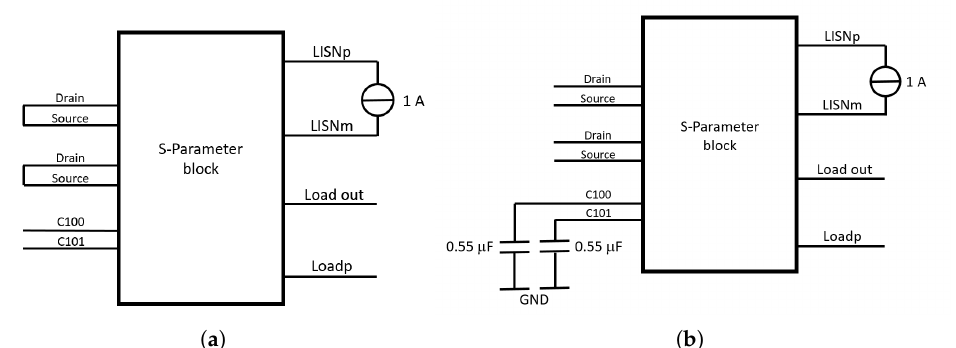
Figure 11. Block diagram for the Validation of the S-Parameter model by using an AC analysis. ( a ) Drain and Source of HS- and LS-switch are shorted and other ports are left open. ( b ) Capacitors C 100 and C 101 are connected and the other ports are left